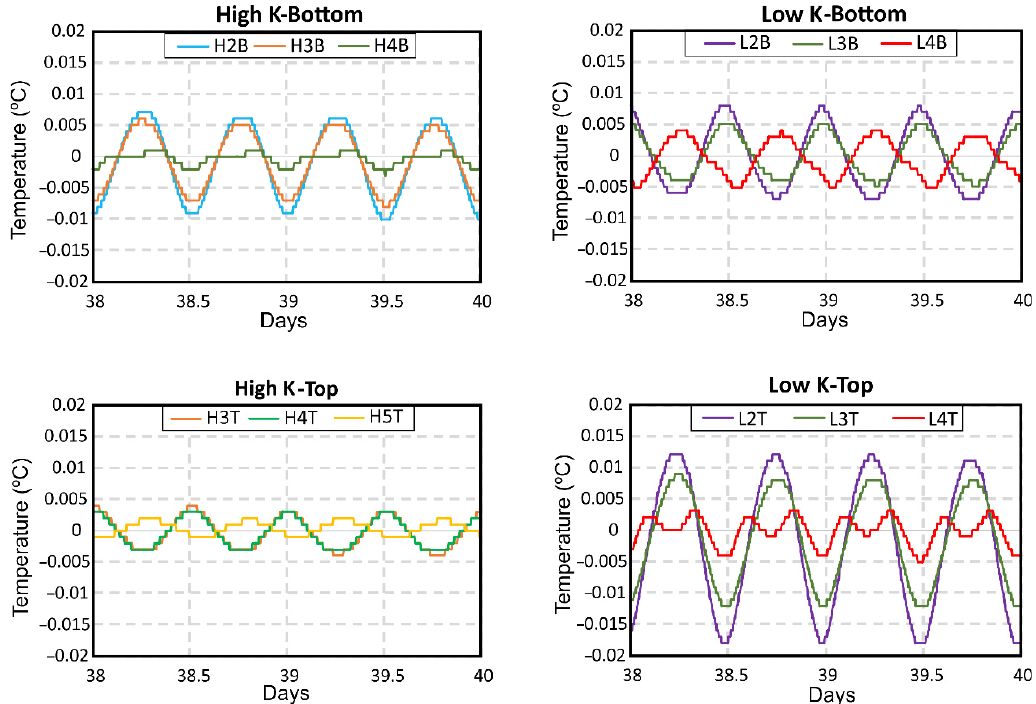
Figure 13. Comparison of the simulation results depending of the location of the observation points (top and bottom of high and low hydraulic conductivity